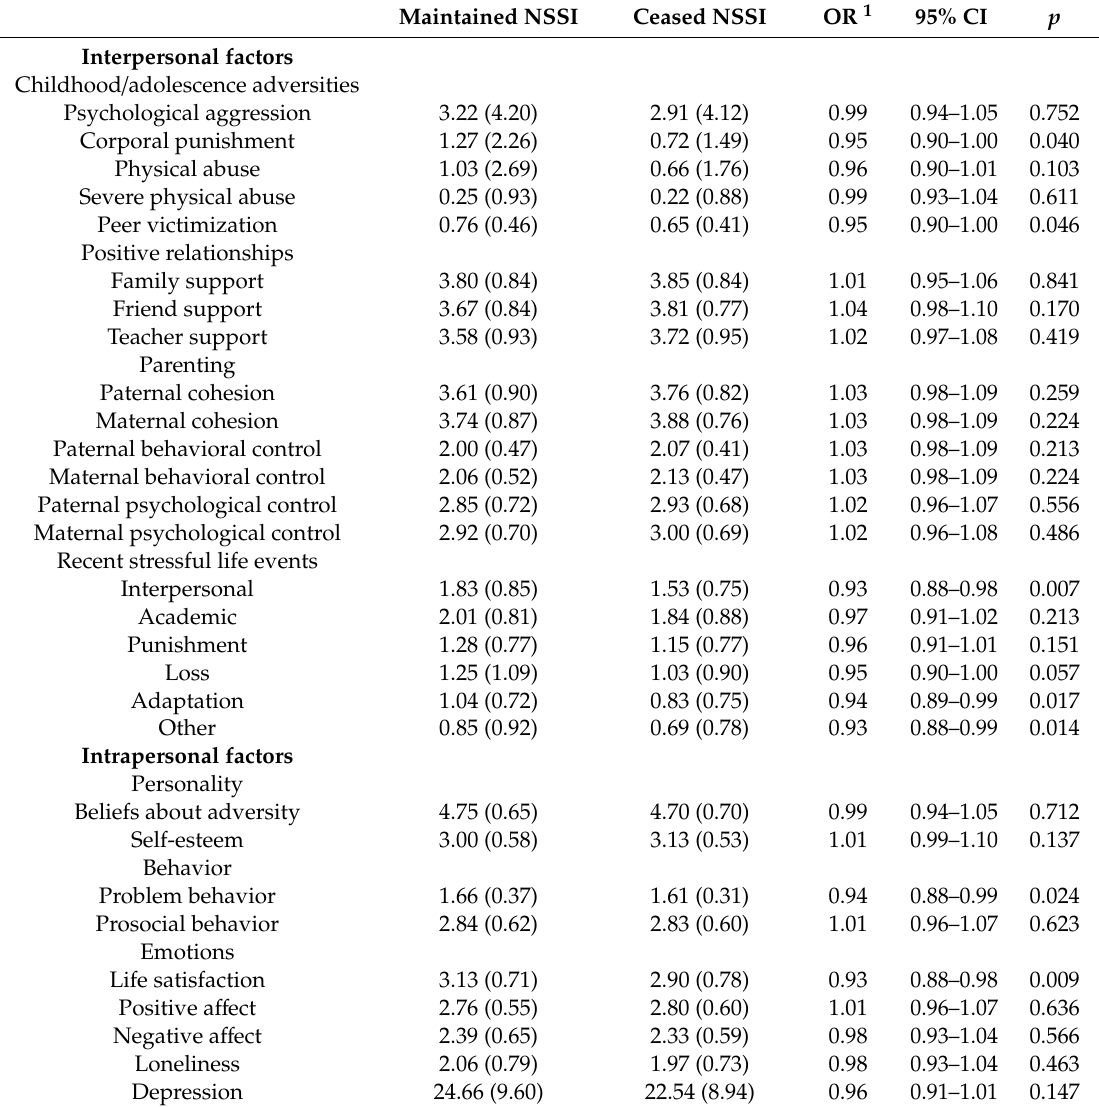
Table 4. Bivariate associations between the predictors and NSSI